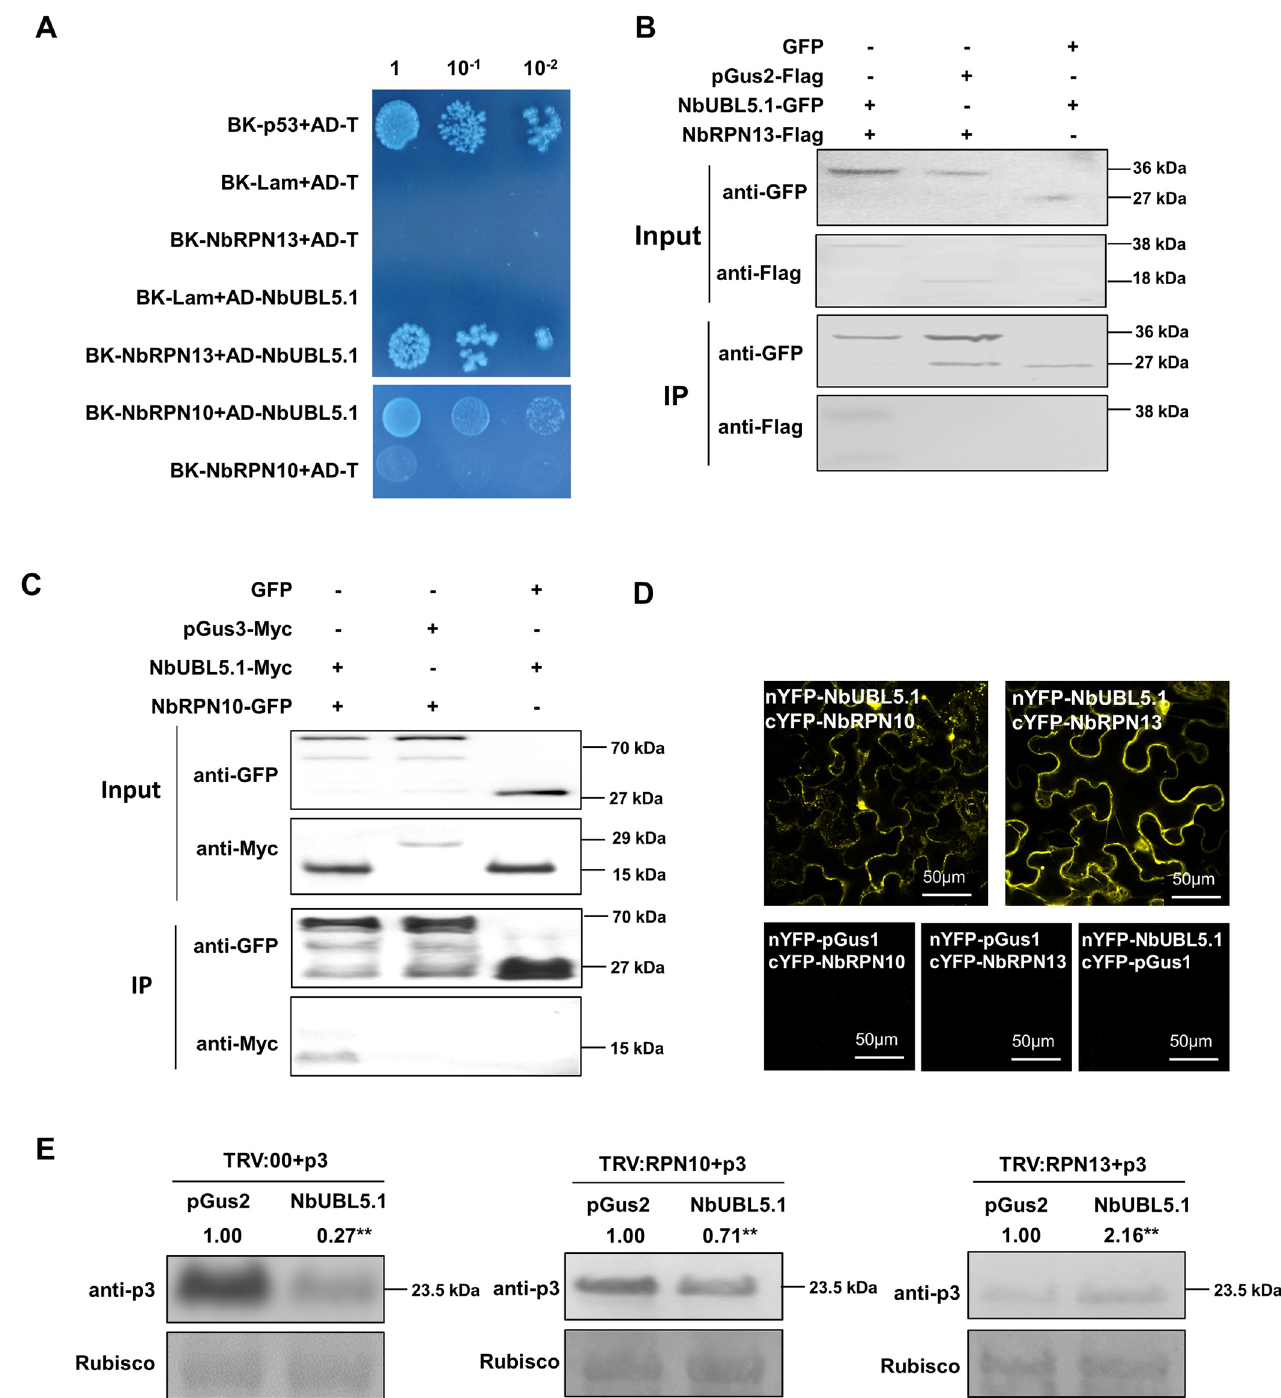
Fig 5. NbUBL5.1 interacts with the ubiquitin receptors in the 26S proteasome, NbRPN10 and NbRPN13, and their silencing inhibits NbUBL5.1-mediated p3 degradation. A. Y2H showing the interaction of NbUBL5.1 with NbRPN10 and NbRPN13. B and C Co-IP showing the interaction of NbUBL5.1 with NbRPN10 and NbRPN13. pGus3 (The N-terminal peptide of Gus with 199 amino acids) was used as control. D. BiFC showing the interaction of NbUBL5.1 with NbRPN10 and NbRPN13. E. On NbRPN10 - and NbRPN13 -silenced plants, a reduction of p3-GFP protein caused by NbUBL5.1-Myc was detected. Results indicate that their silencing inhibits NbUBL5.1-mediated p3 degradation. On non-silenced plants, reduction of p3-GFP protein caused by NbUBL5.1-Myc was used as control. GFP and Myc-fused proteins were detected by western blot. Results are from three biological replicates. Band intensity in blots was calculated by ImageJ based on three replicates. A two-sample unequal variance directional t test was used to test the significance of the difference ( �� , p value <